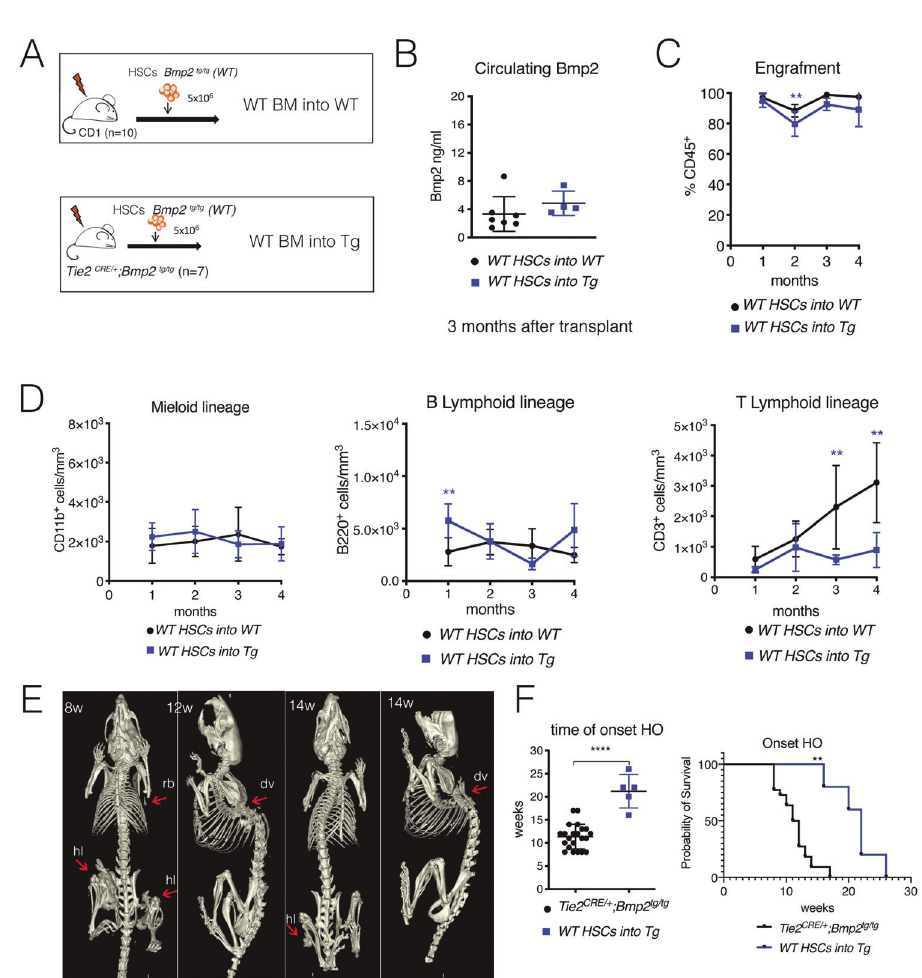
Fig. 4 Transplanting WT BM into transgenic Tie2 Cre/ + ;Bmp2 tg/tg mice delays HO onset. A Schematic representation of transplant assays. WT (CD1) and Tie2 Cre/ + ;Bmp2 tg/tg mice were transplanted with WT BM cells . B Circulating Bmp2 levels are maintained in each group 3 months after transplant. C Hematopoietic cell engraftment. FACS-quanti fi cation of CD45 + cells from PB. Tie2 CRE/ + ;Bmp2 tg/tg and WT mice show similar HSC engraftment. D FACS-quanti fi cation of myeloid (CD11b + ), B Lymphoid (B220 + ) and T Lymphoid (CD3 + ) cells in the two groups of transplanted animals. E Nano-PET-CT imaging of transgenic Tie2 CRE/ + ;Bmp2 tg/tg mice transplanted with WT HSC. These animals develop HO (red arrows) in ribs, hind limbs, and dorsal vertebrae (ribs, rb; hind limbs, hl; and dorsal vertebrae, dv) at 8, 12, and 14 weeks after transplant, suggesting that ectopic bones formation started before transplant. F Representation of the variability of HO onset in non transplanted Tie2 CRE/ + ;Bmp2 tg/tg mice and Tie2 CRE/ + ;Bmp2 tg/tg transplanted with WT HSCs showing signi fi cant delay in the onset of HO (8 – 18 weeks versus 16-28w). Kaplan-Meier curve showing that Tie2 CRE/ + ;Bmp2 tg/tg mice transplanted with WT HSCs survive 10 weeks longer on average non-transplanted transgenic mice. C , D Two-way ANOVA and Sidak ’ s correction ** P < 0.01; F unpaired t test, two tails, mean ± SD. t test **** P < 0.0001. E Survival curve and survival curve analysis, ** P <